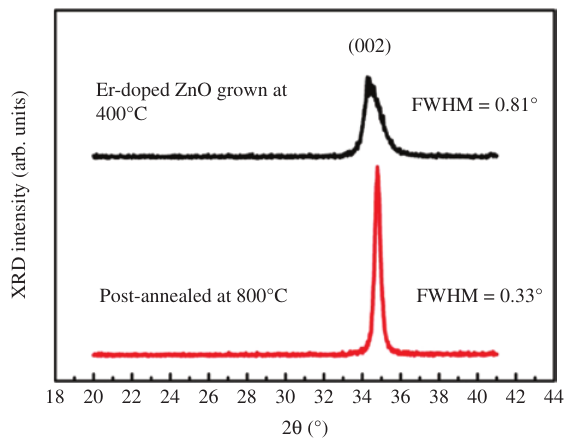
Figure 2: XRD patterns of the as-deposited and post-annealed films.